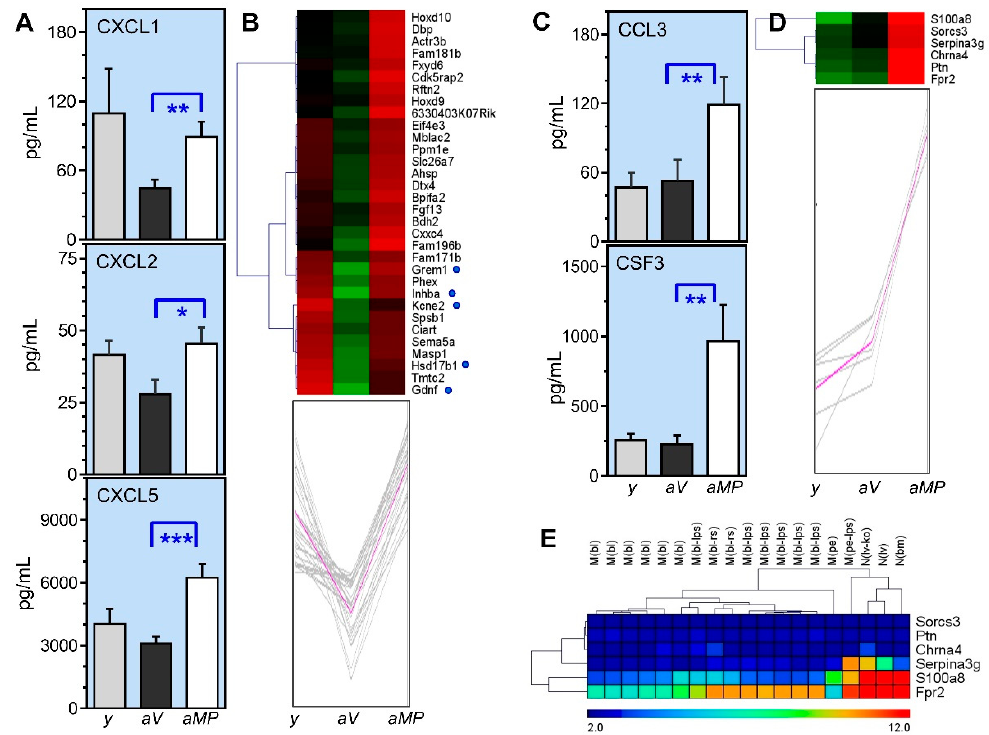
Figure 4. Parity-dependent circulating cytokines levels and related gene expression in aged ovaries: ( A , C ) Mean ( ± SEM) serum levels of the indicated cytokines in female young ( y ), aged virgin ( aV ), and aged multiparous ( aMP ) mice are shown with their respective 32-genes ( B ), and the six-genes ( D ) expression heatmaps and centroid clusters at the bottom obtained with same settings as that of Figure 2. Significant di ff erences among the cytokine levels were determined after two-tailed Mann–Whitney tests, (*) p < 0.05, (**) p < 0.01, and (***) p < 0.001. Blue dots in the heatmap of ( B ) indicate genes with a cytokine-like pattern, but evidence of follicle function. Note that the sum of 27-genes (Figure 2B) and the 32 and 6 (38) genes in ( B , D ) complete the 65 DEGs of a higher expression in multiparous ovaries (see Section 3.3). The heatmap in ( E ) show the expression levels of the six-gene clusters in peritoneal and intact LPS-treated J774.1 macrophages (M label) and neutrophils (N label). Multiple samples correspond to di ff erent LPS doses and incubation times, as described in the Ref-DIC database (http://refdic.rcai.riken.jp/profile.cgi).